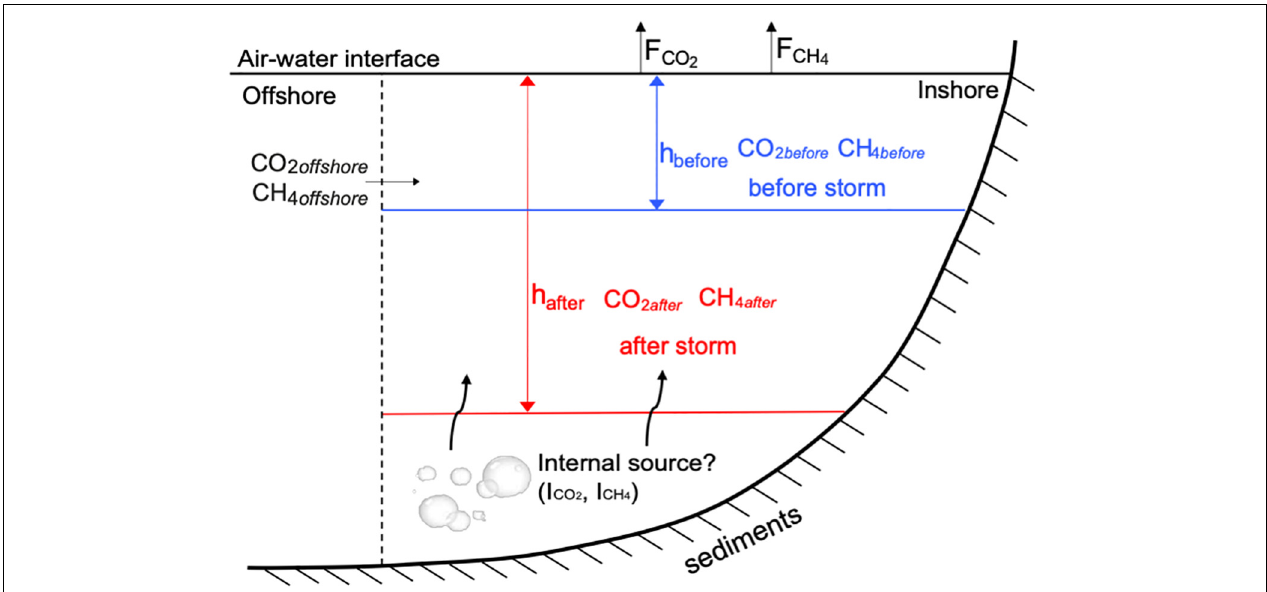
FIGURE 2 | Scheme over the budget approach evaluating the internal sources and sinks of CO 2 and CH 4 in TZS coastal waters.